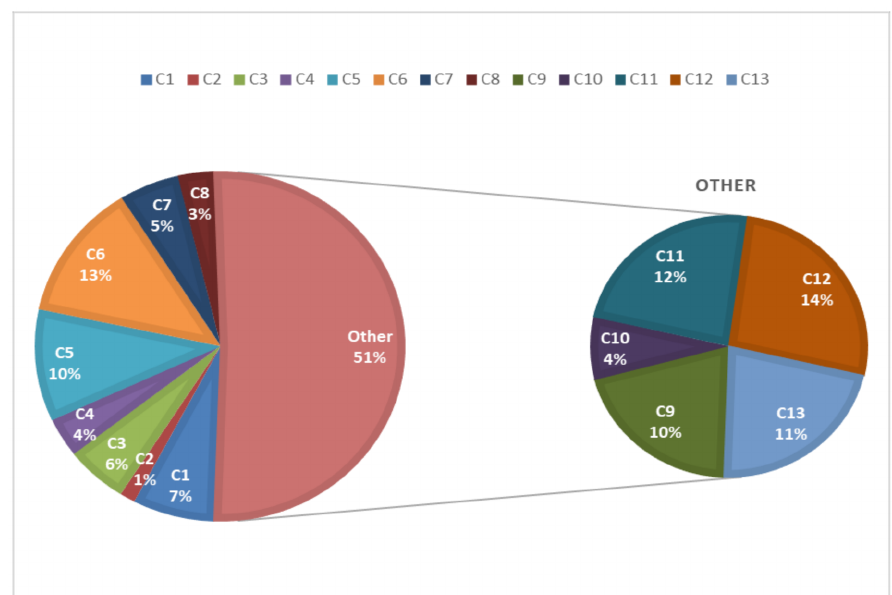
Figure 5. Figure depicting the influence of challenges in terms of